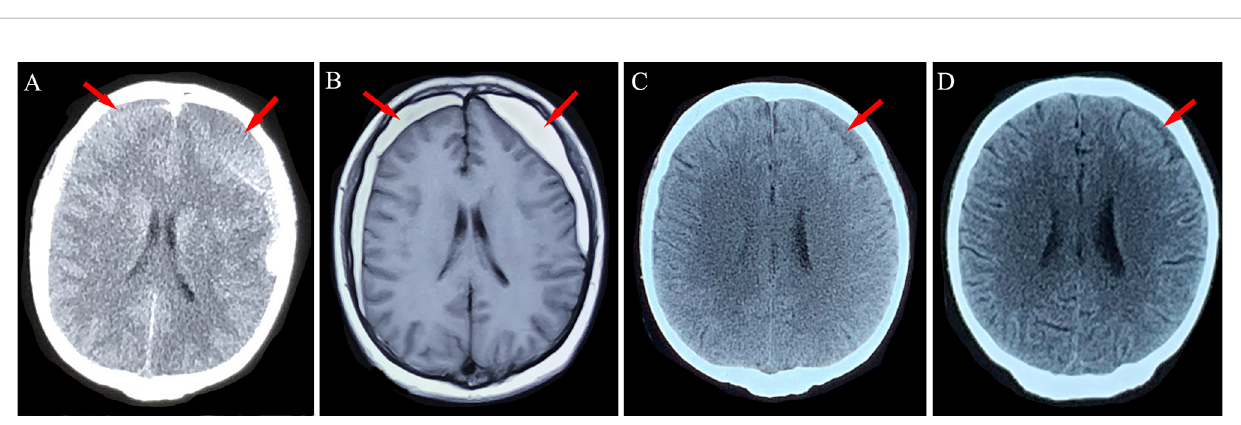
FIGURE 2 | Neuroimaging fi ndings for Patient 1. (A) Chronic subdural hematoma (red arrows) was detected in the bilateral frontotemporal lobes after head trauma. (B) After 4 weeks of atorvastatin treatment, the left-side hematoma was slightly absorbed. (C, D) Absorption of the hematoma after 8 weeks and 12 weeks of conservative treatment using atorvastatin plus low-dose dexamethasone.